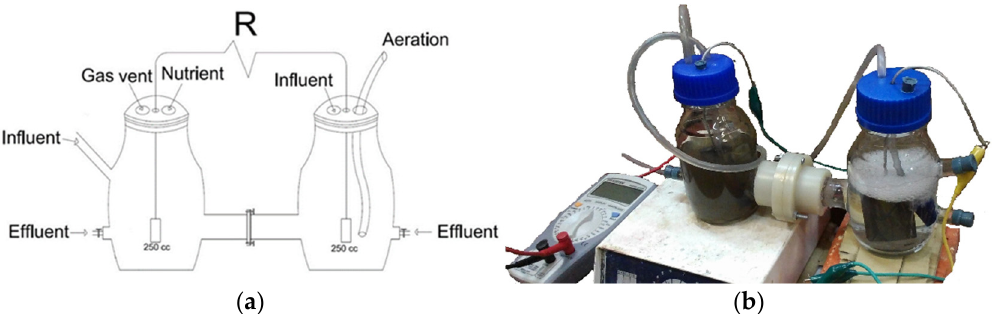
Figure 1. ( a ) Schematic and ( b ) original apparatus of the MFC